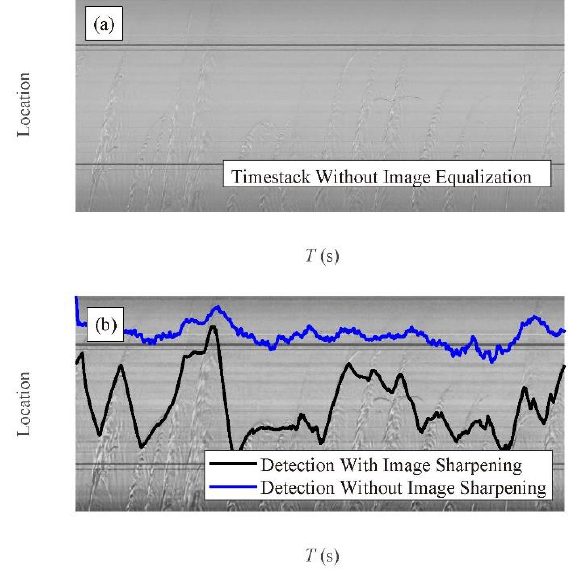
Figure 3. An example application of image sharpening and image equalization. ( a ) Time-stack image without image equalization. ( b ) Edge identification comparison between with and without image sharpening, using the time-stack image under image equalization.